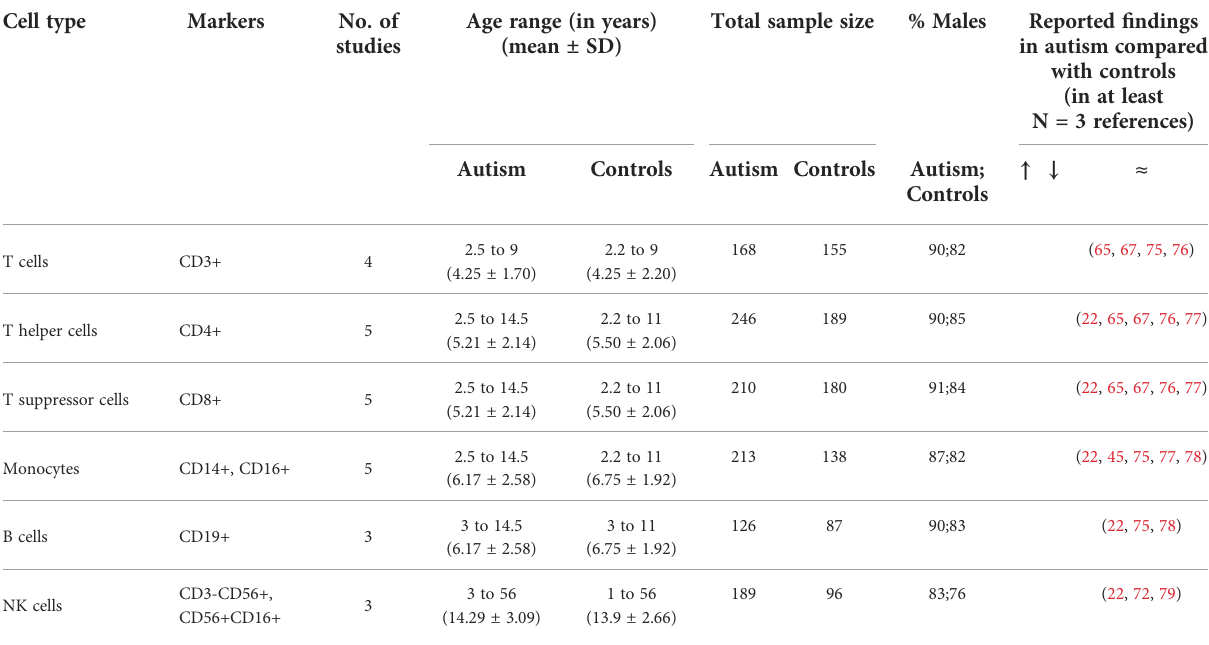
TABLE 3 Percentages of blood immune cells in autism under baseline conditions compared with